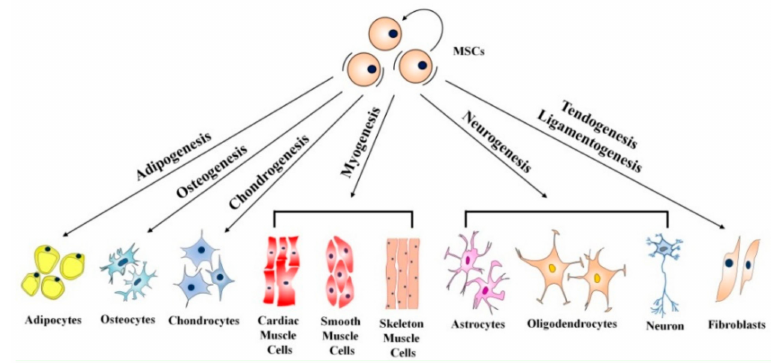
Figure 8. The differentiation potential of mesenchymal stem cells [13]. Copyright 2018 Springer